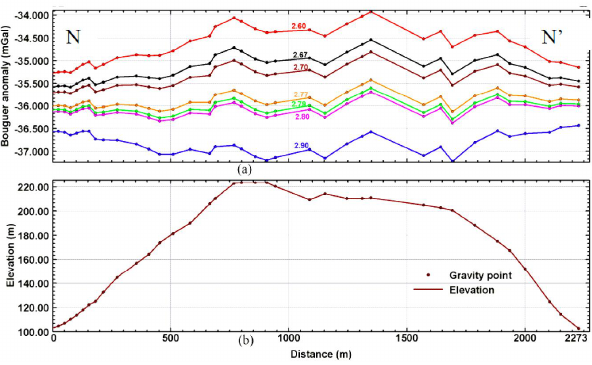
Fig. 4. Determination of the bulk density of the studied domain us- ing the Nettleton Method. (a) Computed Bouguer anomalies along NN using different densities. The location of this profile is shown in Fig. 5. (b) Topography of the profile with location of the gravity points.